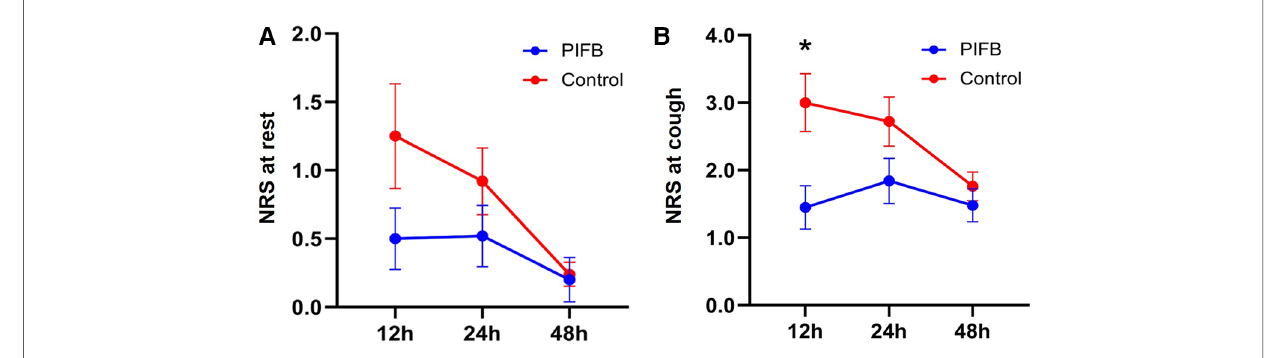
FIGURE 3 Postoperative pain score. ( A ) at rest. ( B ) upon coughing. Data were analyzed using 2-way ANOVA, followed by Sidak ’ s multiple comparisons for each time point. Data are shown as mean±standard error of the mean. * p <0.05. NRS, numeric rating scale and PIFB,pecto-intercostal fascial